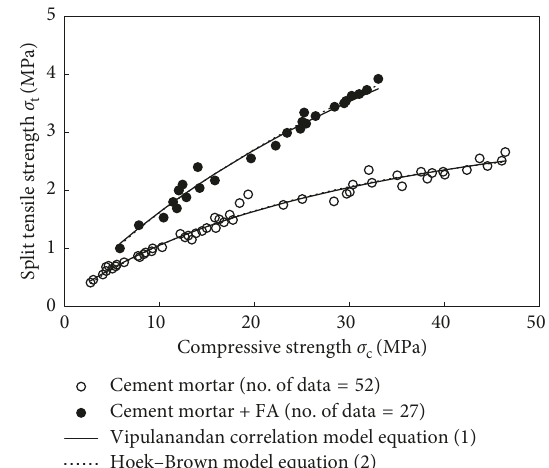
Figure 12: Variation of split tensile and compressive strengths of cement mortar with and without fly ash